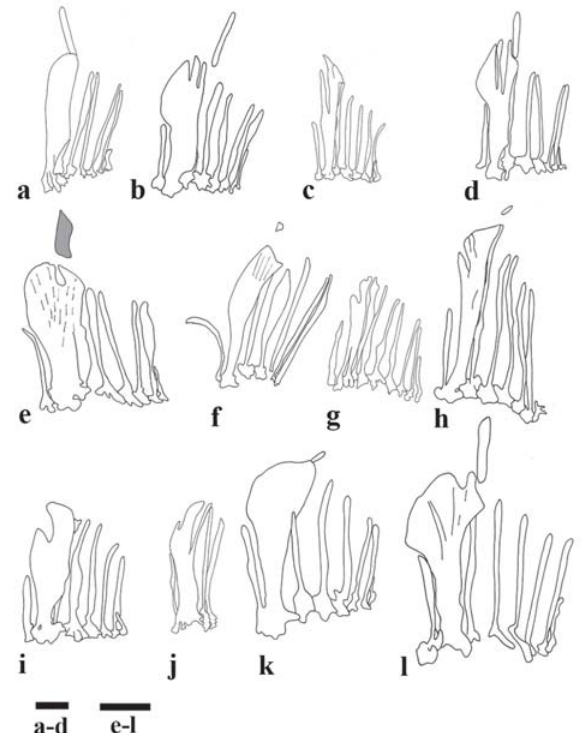
Fig. 9. Lateral view of gonopodial suspensorium in: a ) Alfaro cultratus , TU 24927; b ) Pseudoxiphophorus litoperas , USAC 1813; c ) Brachyrhaphis terrabensis , AMNH 2503; d ) Pseudoxiphophorus bimaculatus , CAS 78795; e ) Pseudoxiphophorus obliquus , LSUMZ 14339; f ) Heterandria formosa , TU 24002; g ) Brachyrhaphis olomina , TU 24997; h ) Gambusia affinis , TU 114758; i ) Brachyrhaphis rhabdophora , TU 84483; j ) Pamphorichthys araguaiensis , MCP 40919; k ) Phallichthys fairweatheri , USAC 1797; l ) Brachyrhaphis episcopi , SU 50303. Scale bars = 1